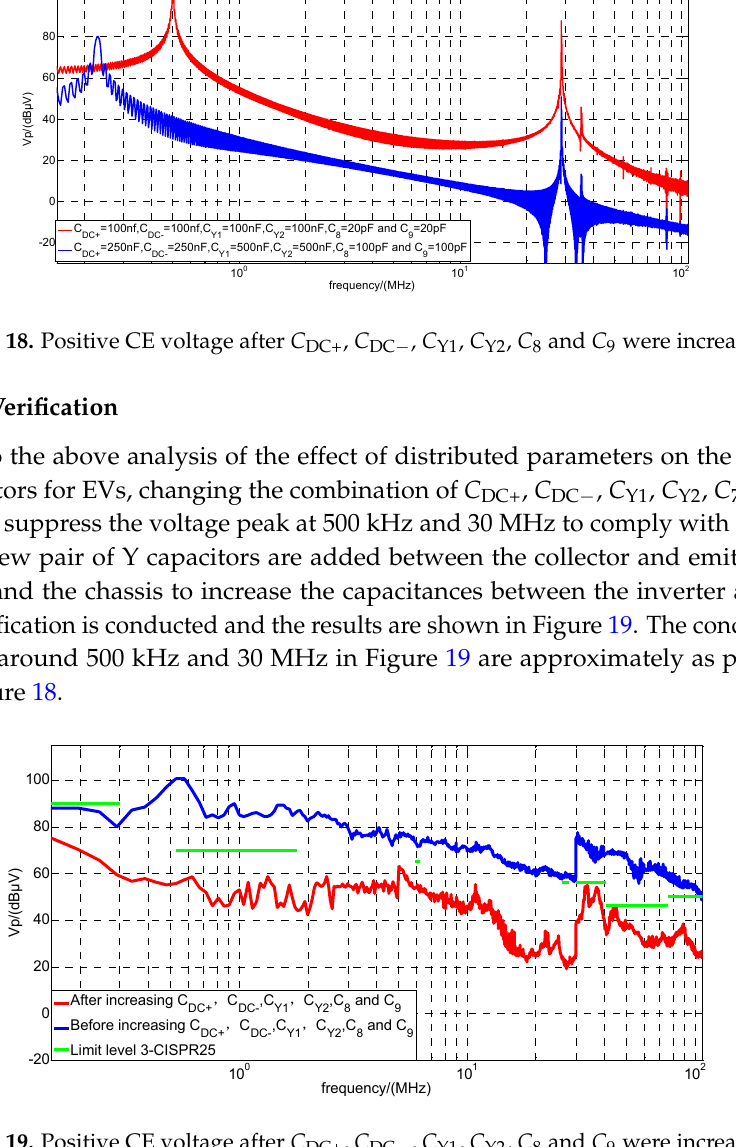
4.2.6. The Effect of the Combination of C DC+ , C DC − , C Y1 , C Y2 , C 8 and C 9